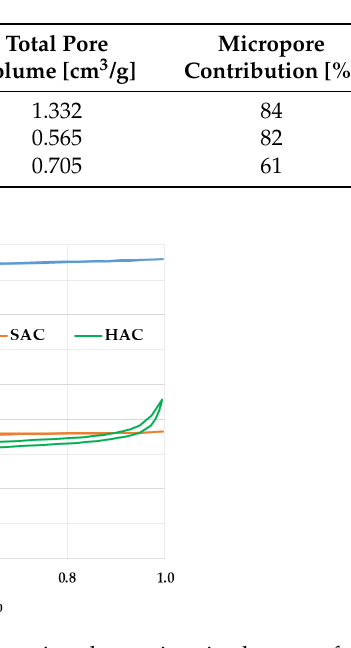
Figure 1. Low-temperature N 2 adsorption-desorption isotherms of PAC, SAC and HAC activated biocarbons.